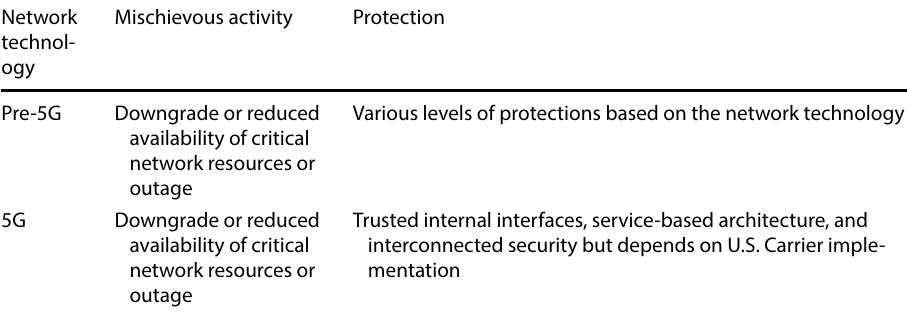
Table 9 Core network control correctness